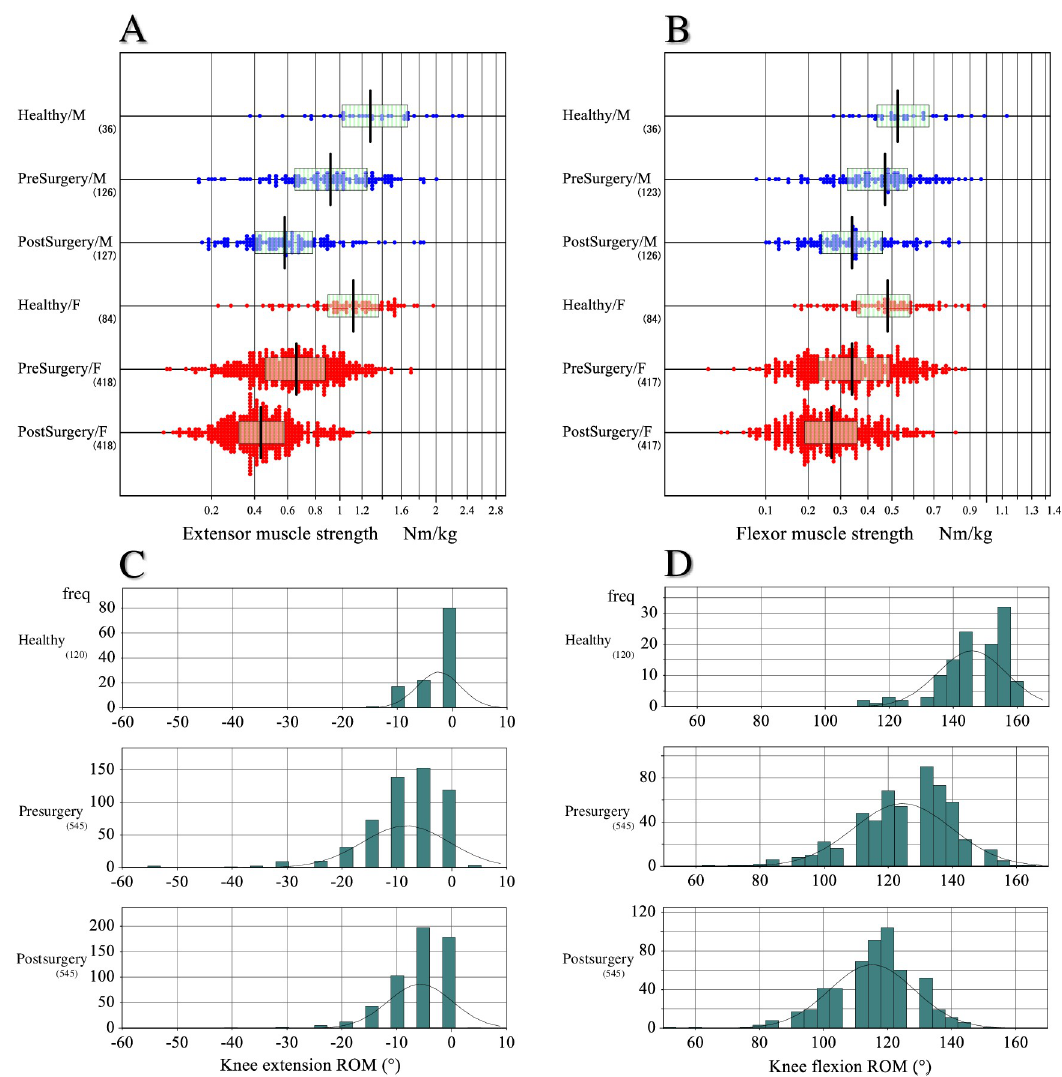
Fig 4. Comparison of knee muscle strength and ROM between three groups. The measured strengths of extensor (A) and flexor (B) muscles were compared between three groups: Healthy controls and patients before and after the surgery. The values were partitioned by gender. The x-axis was transformed to the power of 0.5 to make their distribution near Gaussian. The box and center line represent the mid-50% range and median of each subgroup, respectively. Similarly, the range of motion (ROM) of extension (C) and flexion (D) was compared between the three groups. As the test results were recorded discretely for every 5˚, the distribution is shown by histogram.